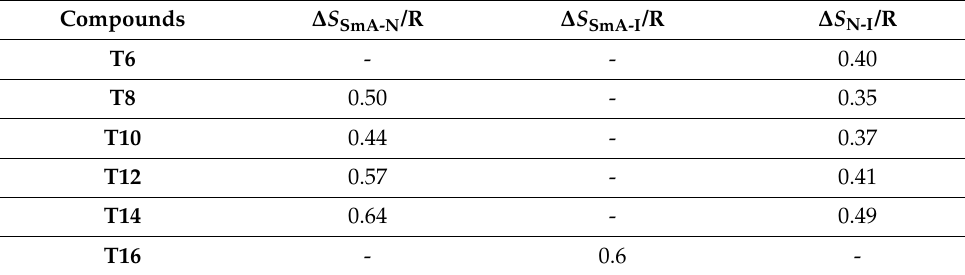
Table 2. Normalized entropy changes of transitions for present series Tn